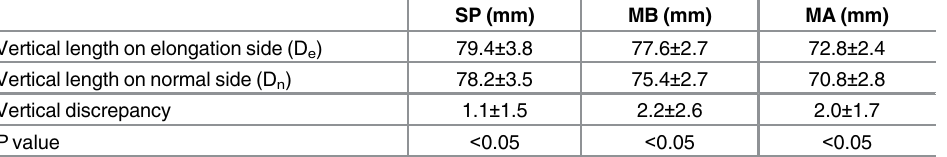
Table 3. Measurement of the vertical discrepancy of asymmetry site in SP, MB, and MA regions after virtual Me point correction. SP (mm) MB (mm) MA (mm) Vertical length on elongation side (D e ) 79.4 ± 3.8 77.6 ± 2.7 72.8 ± 2.4 Vertical length on normal side (D n ) 78.2 ± 3.5 75.4 ± 2.7 70.8 ± 2.8 Vertical discrepancy 1.1 ± 1.5 2.2 ± 2.6 2.0 ± 1.7 P value < 0.05 <